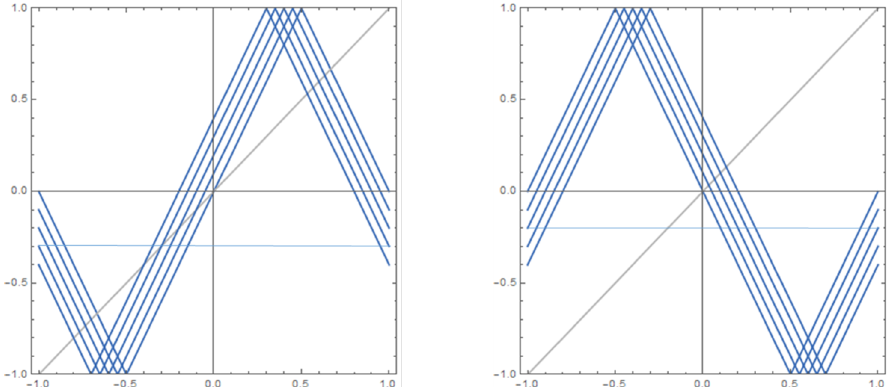
Figure 2. Graphs of τ − 1, s , r for s = 2, and r = 0, − 0.05, − 0.1, − 0.15, − 0.2, on the left and τ 1, s , r for s = 2, r = 0,0.05,0.1,0.15,0.2, on the right. The growth number is equal to 2 in every case, and, therefore, give origin to the same topological entropy log2. Note that τ ρ , s , r ( − 1 ) = τ ρ , s , r ( 1 ) , in every